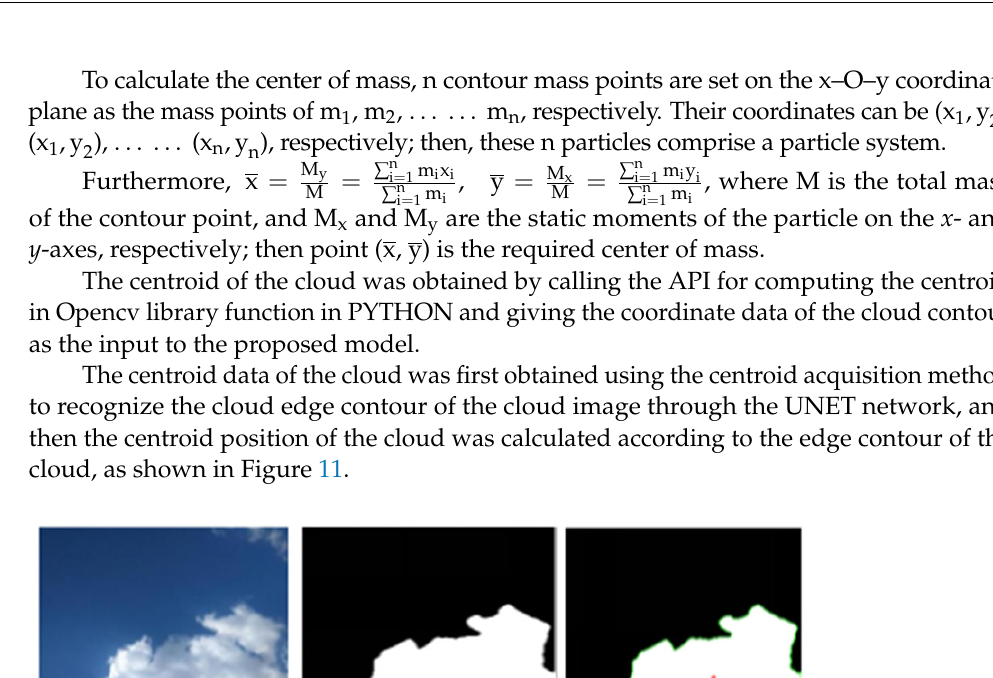
Figure 11. Method of calculating the centroid position. From the images captured at 10 s intervals, we manually selected 11 images with whole clouds. Continuous photos were obtained by using the centroid acquisition method in succession; a data record contains 11 triples of information including cloud centroid longitude, cloud centroid dimension, and time, as shown in Figure 12.